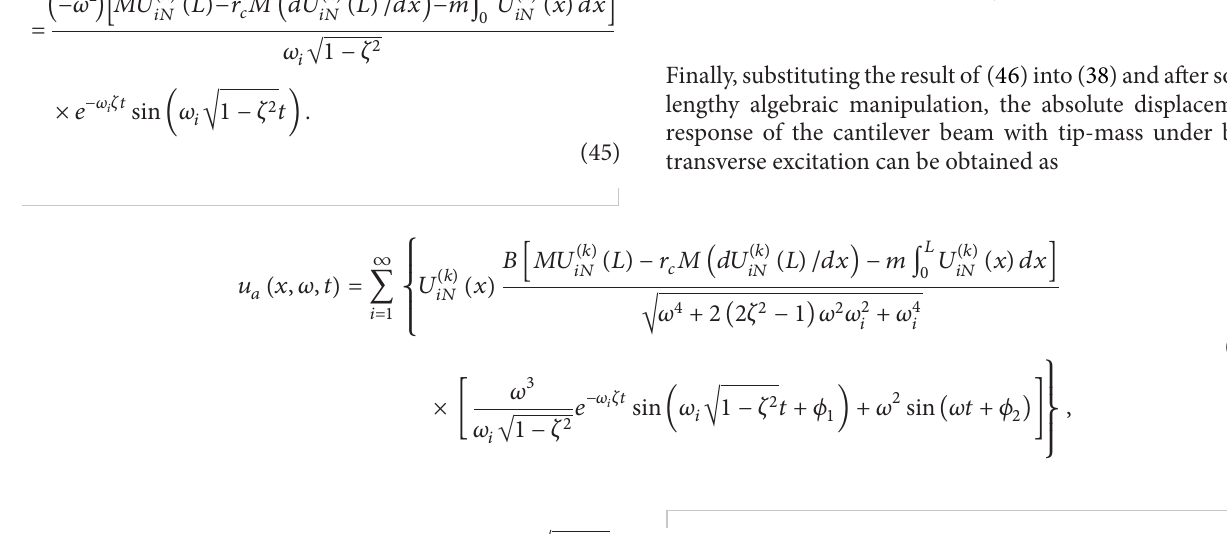
Table 2: Characteristic properties of the cantilever beam including